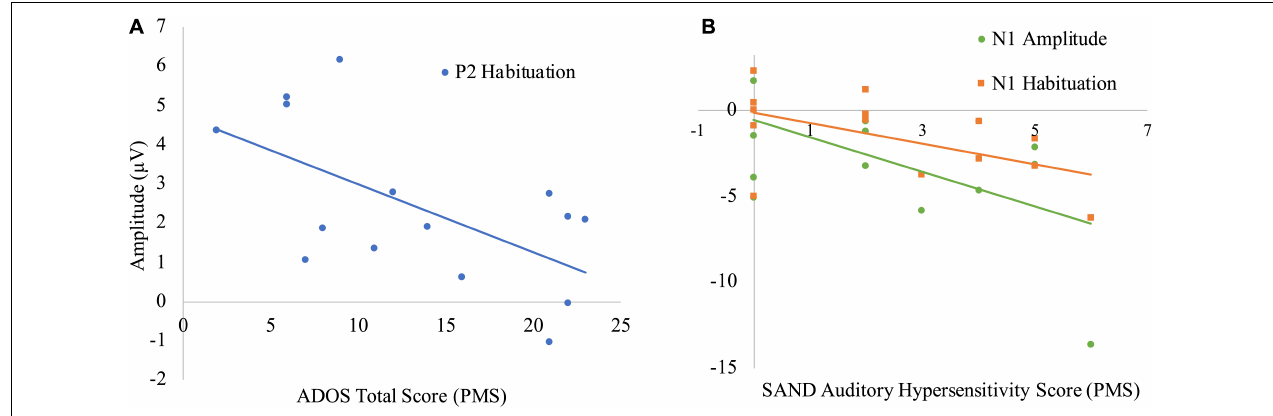
FIGURE 4 | Correlations between electrophysiologic and behavioral measures in PMS. (A) Negative correlation between P2 1 − 2 habituation and ADOS total score. (B) Negative correlation between N1 1 amplitude and SAND auditory hypersensitivity, as well as N1 1 − 2 habituation and SAND auditory hypersensitivity.